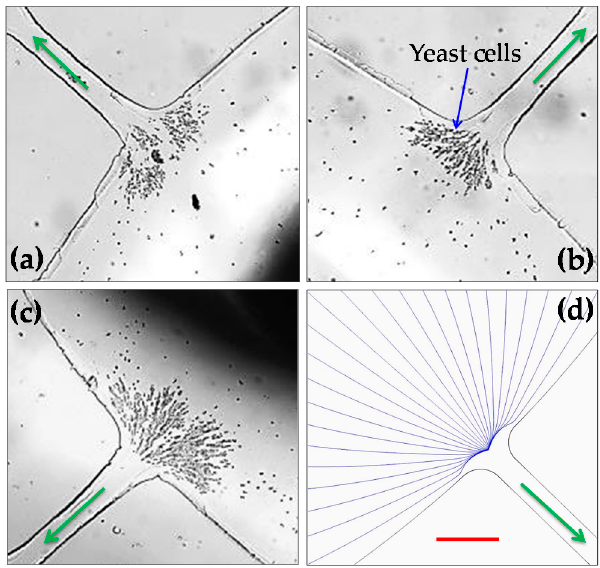
Figure 5. Electrokinetic concentration of live yeast cells at different central reservoir-microchannel junctions of the stacked microfluidic device under a 25-V DC-biased 250-V AC voltage: ( a ) snapshot image in Layer A (see Figure 1); ( b ) snapshot image in Layer B; ( c ) snapshot image at a different reservoir-microchannel junction of Layer A; and ( d ) numerically predicted trajectories at any reservoir-microchannel junction. The arrows indicate the fluid and cell moving directions. The scale bar represents 100 μ m and applies to all images.